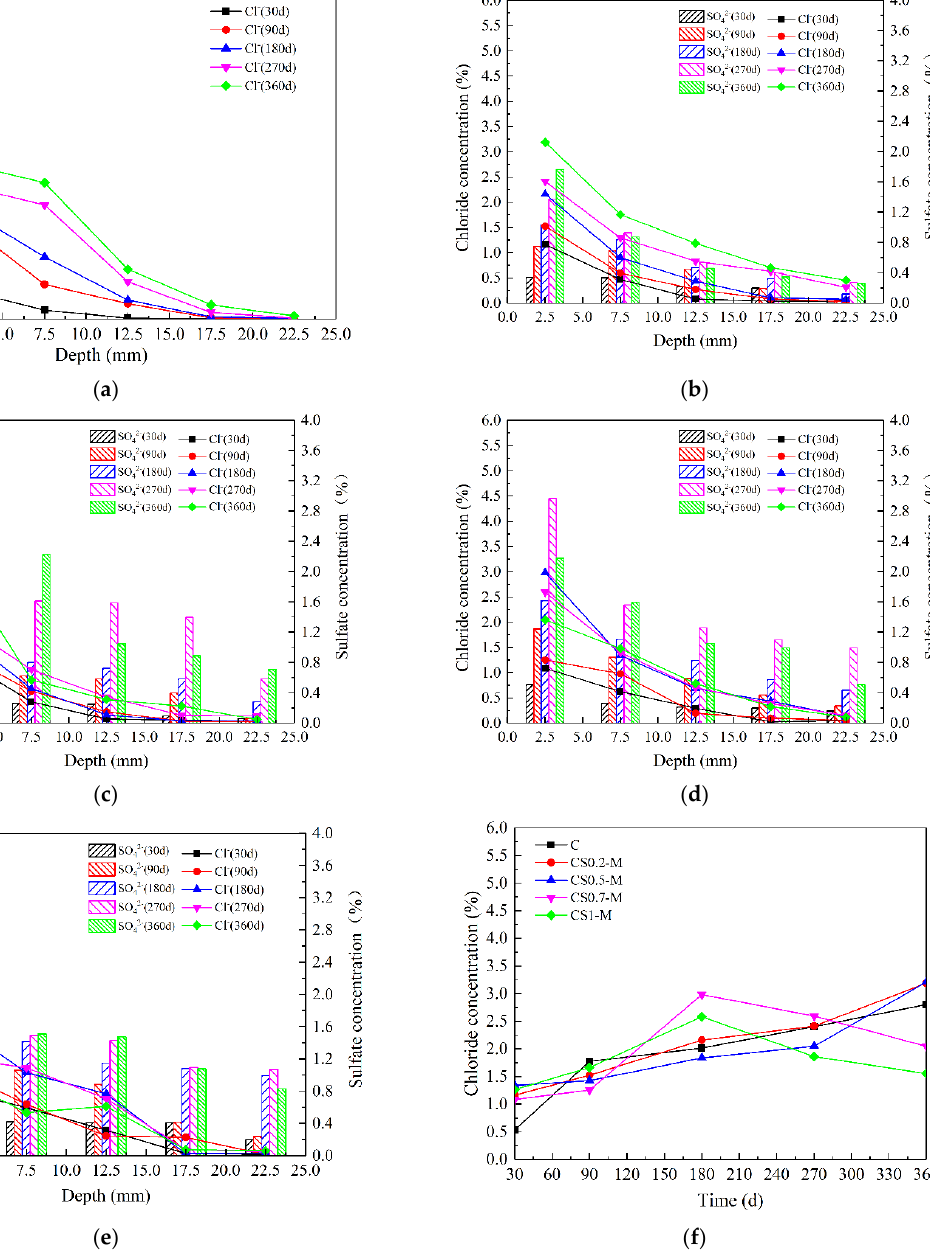
Figure 6. Results of Cl − and SO 42 − concentrations: ( a ) C; ( b ) CS0.2-M; ( c ) CS0.5-M; ( d ) CS0.7-M; ( e ) CS1-M, and ( f ) ion content at 2.5